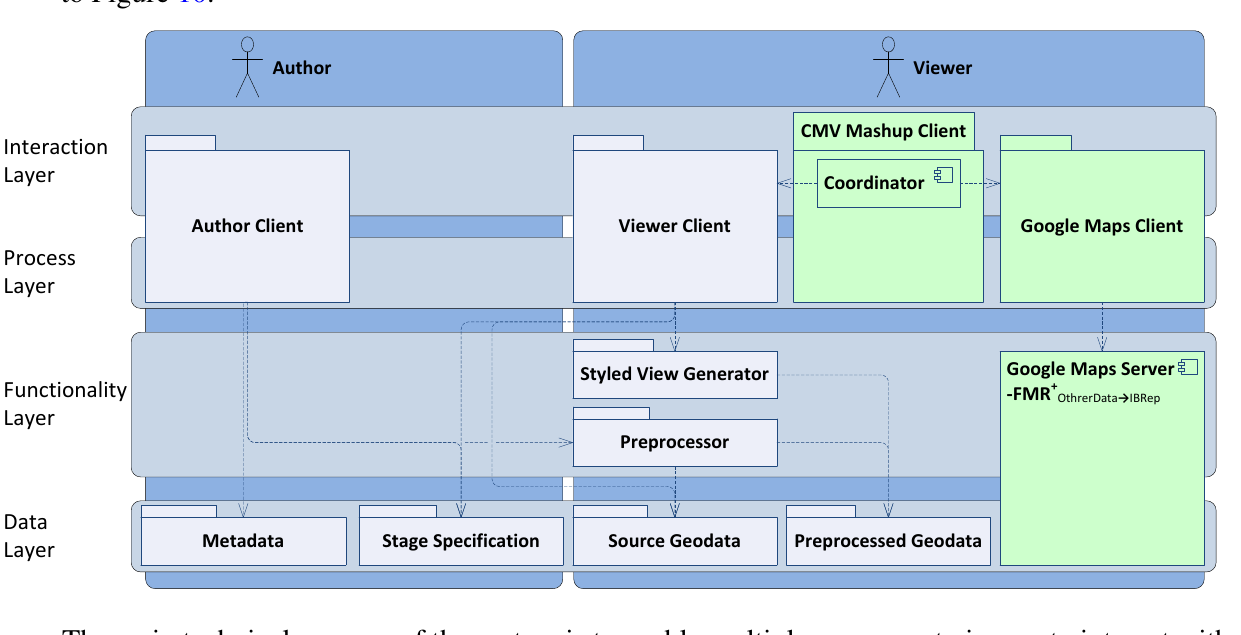
Figure 13. Overview of the logical software architecture of a 3DGeoVS based on SSI demonstrating a mashup realizing CMV and integrating geodata and services from different sources on the interaction layer. Green background color indicates elements added relative to Figure